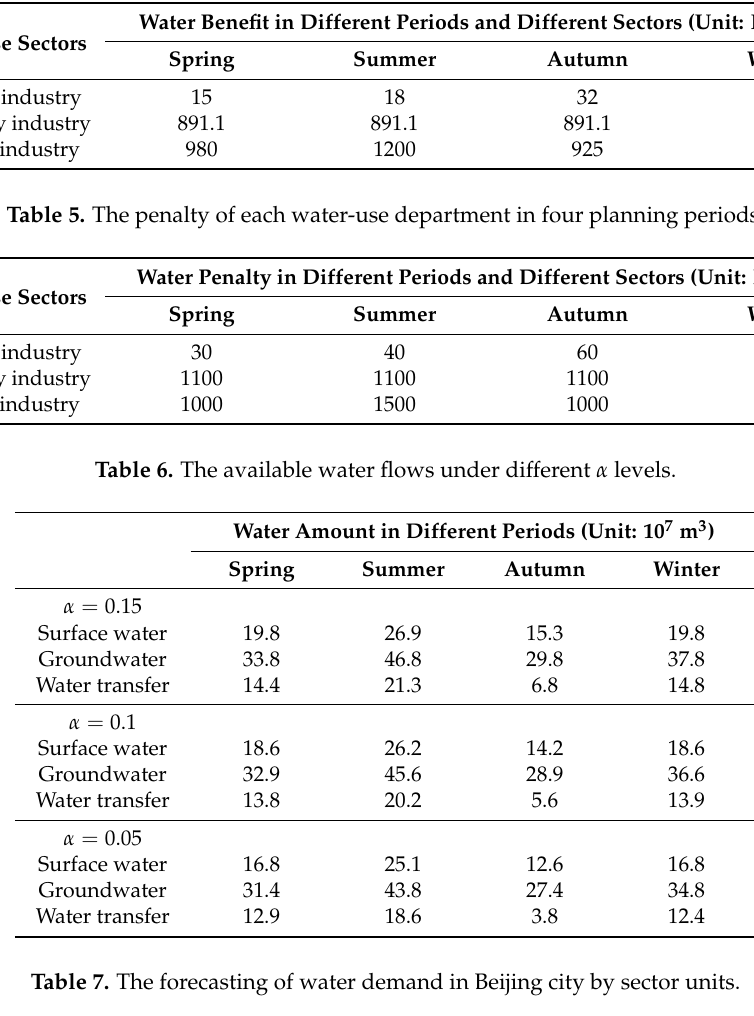
Table 4. The benefits of each water-use department in four planning periods.